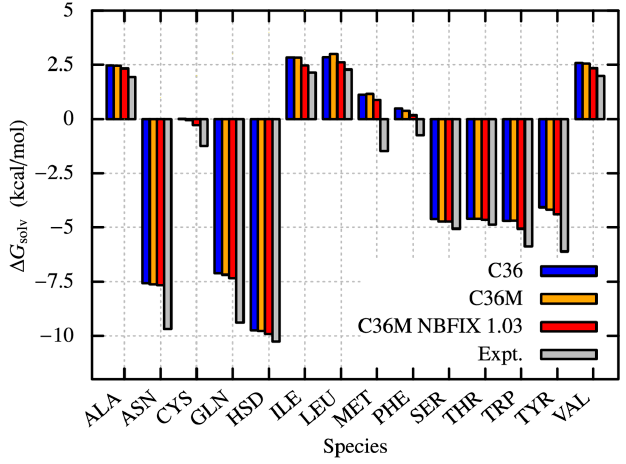
Figure 8. Solvation free energies ( Δ𝐺 (cid:2929)(cid:2925)(cid:2922)(cid:2932) ) of amino acid analogues computed using free energy perturbation (FEP) method.